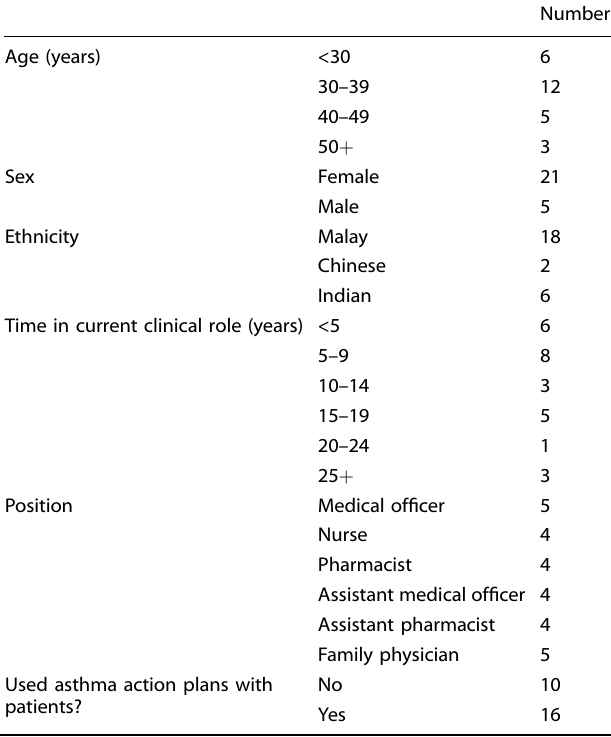
Table 1. Demographic data of participants ( N = 26).